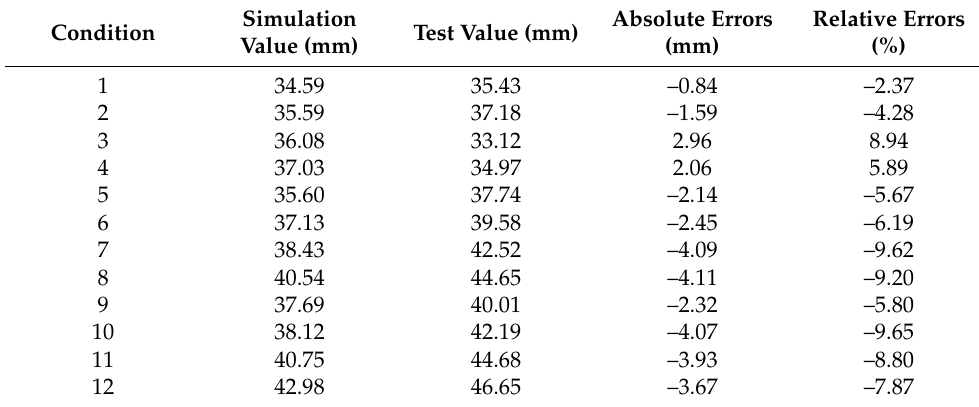
Table 7. The validation of